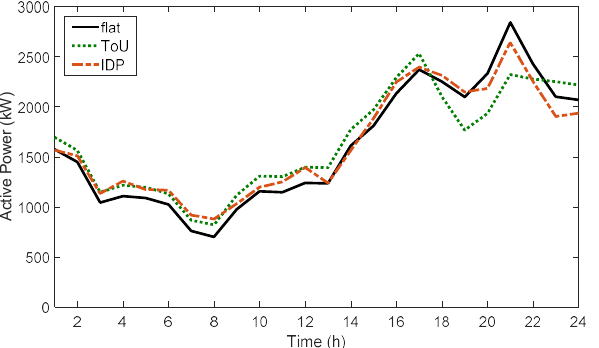
Figure 9. The impact of DR programs on total load profile with PV generation.